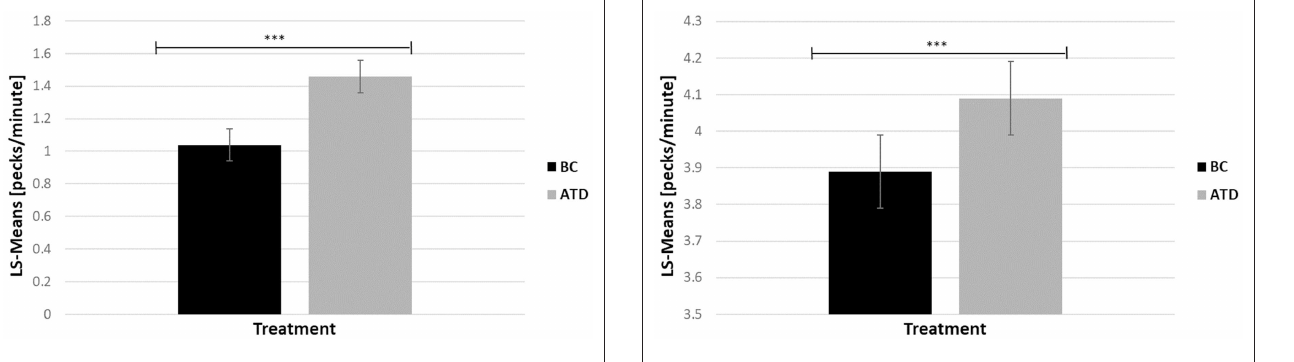
baseline levels of FP behavior prior to treatment as a covariate.